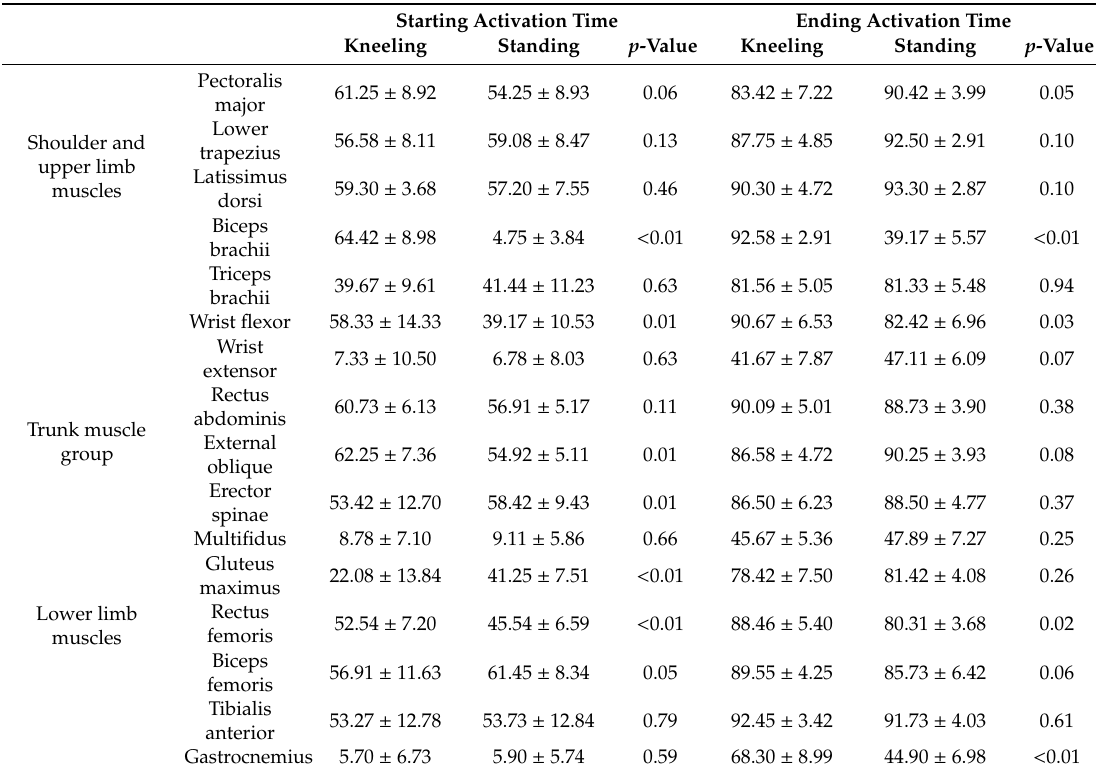
Table 1. Comparison of the starting and ending activation time for each muscle group in di ff erent paddling positions (unit: % paddle cycle).